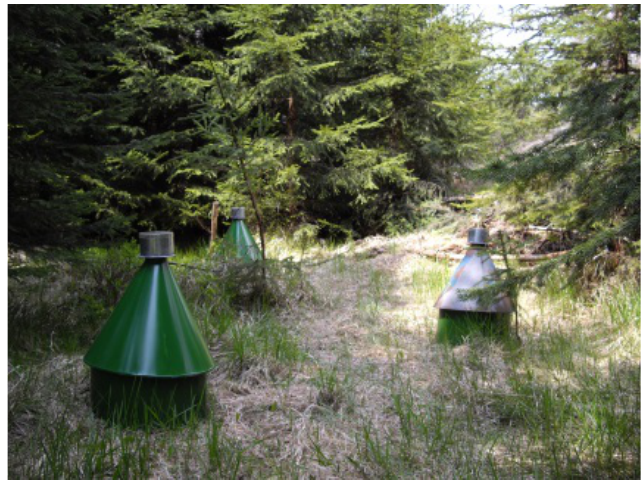
Figure 2. The soil photoeclectors that were used to collect